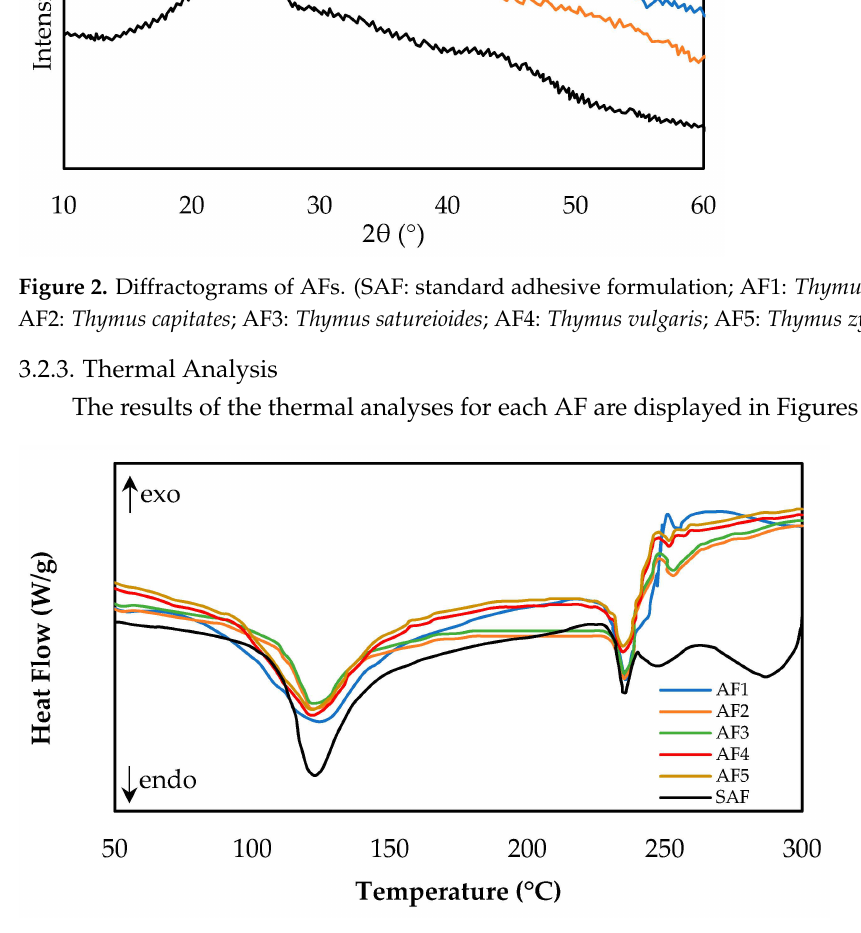
Figure 3. Differential Thermal Analysis of AFs. (SAF: standard adhesive formulation; AF1: Thy- mus bleicherianus ; AF2: Thymus capitates ; AF3: Thymus satureioides ; AF4: Thymus vulgaris ; AF5: Thymus zygis